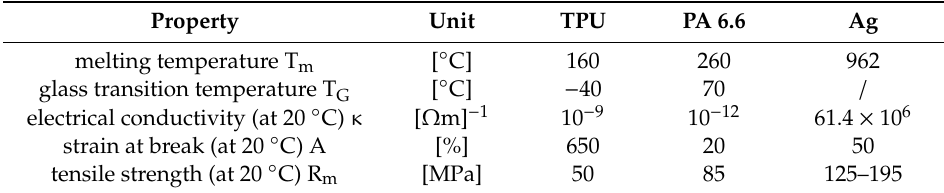
Table 1. Mechanical and electrical properties of the used materials